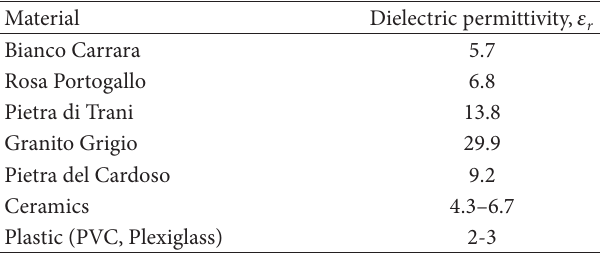
T 1: Relative dielectric permittivity of different